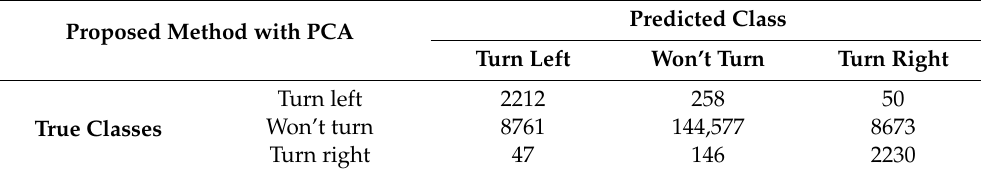
Table 7. The confusion matrix of the proposed method with